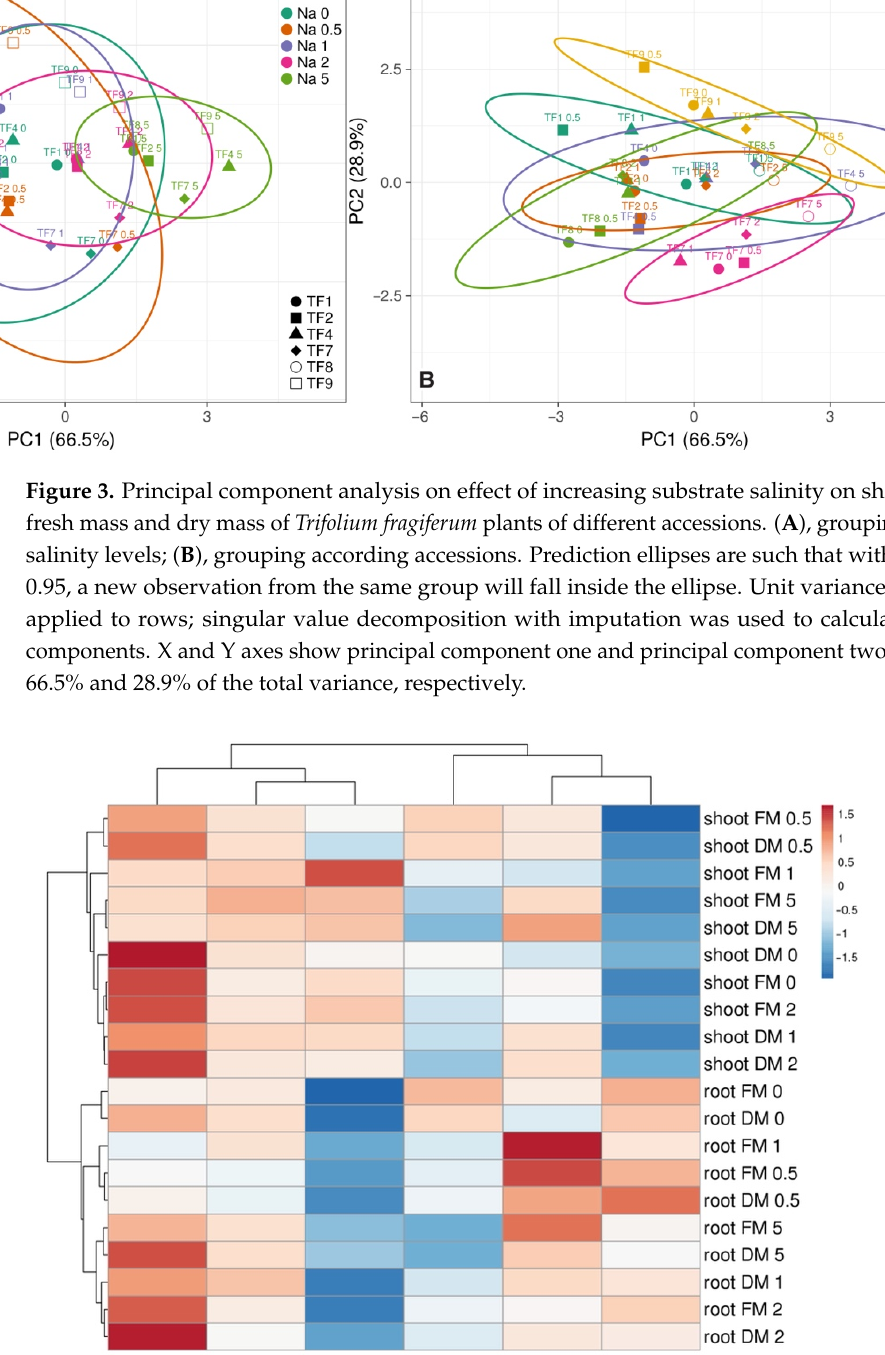
Figure 4. Generated heat map and cluster analysis on effect of increasing substrate salinity on shoot and root fresh mass and dry mass of Trifolium fragiferum plants of different accessions. Hierarchical clusters were generated by average linkage method with correlation distance. Color scale shows relative intensity of normalized parameter values. FM, fresh mass; DM, dry mass.